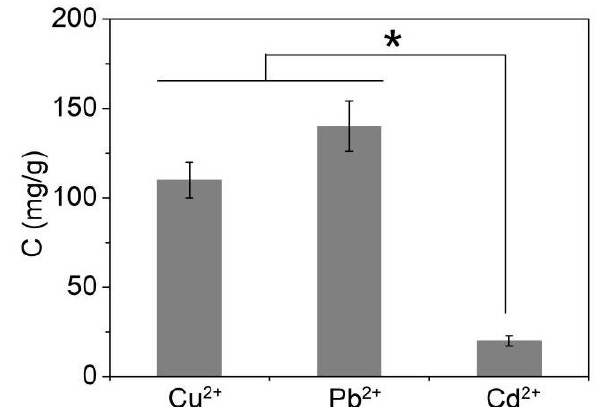
Figure 5. The adsorption capacity of magnetic MIL-68(Ga) in the removal of different heavy metal ions (50 mg/L of metal ions, 200 mg/mL of adsorbent, 1 mL solution, pH = 7, room temperature, 30 min of incubation time). The asterisk (*) indicates significant difference between the groups ( p < 0.05).